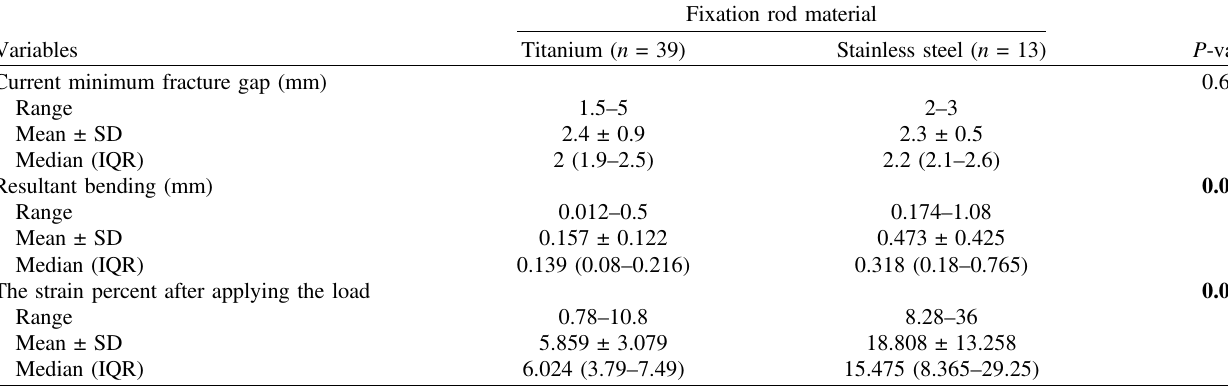
Table 2. The correlations between the rod material and procedures measures.